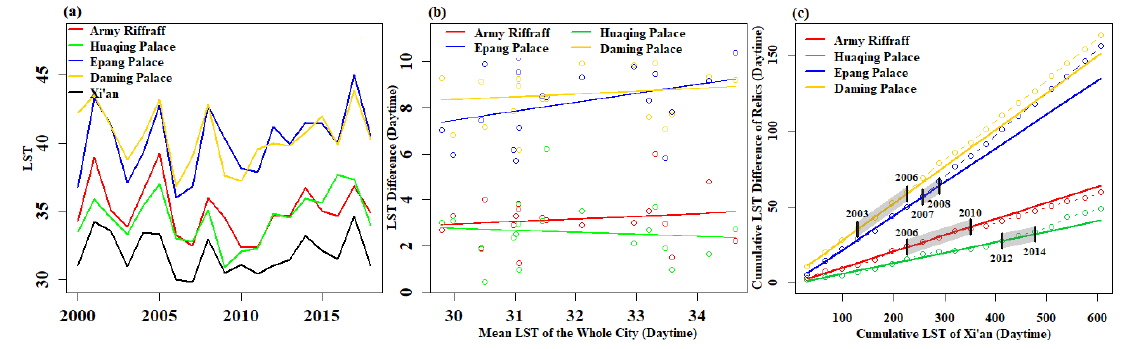
Figure 7. The mean LST values of different relics ( a ). The relationships between LST differences between different sites and the whole city with the mean LST for Xi’an ( b ). Double temperature curves for cumulative values of LST differences and the mean LST of Xi’an ( c ). The grey area represents the 95% confidence range of the breakpoint.